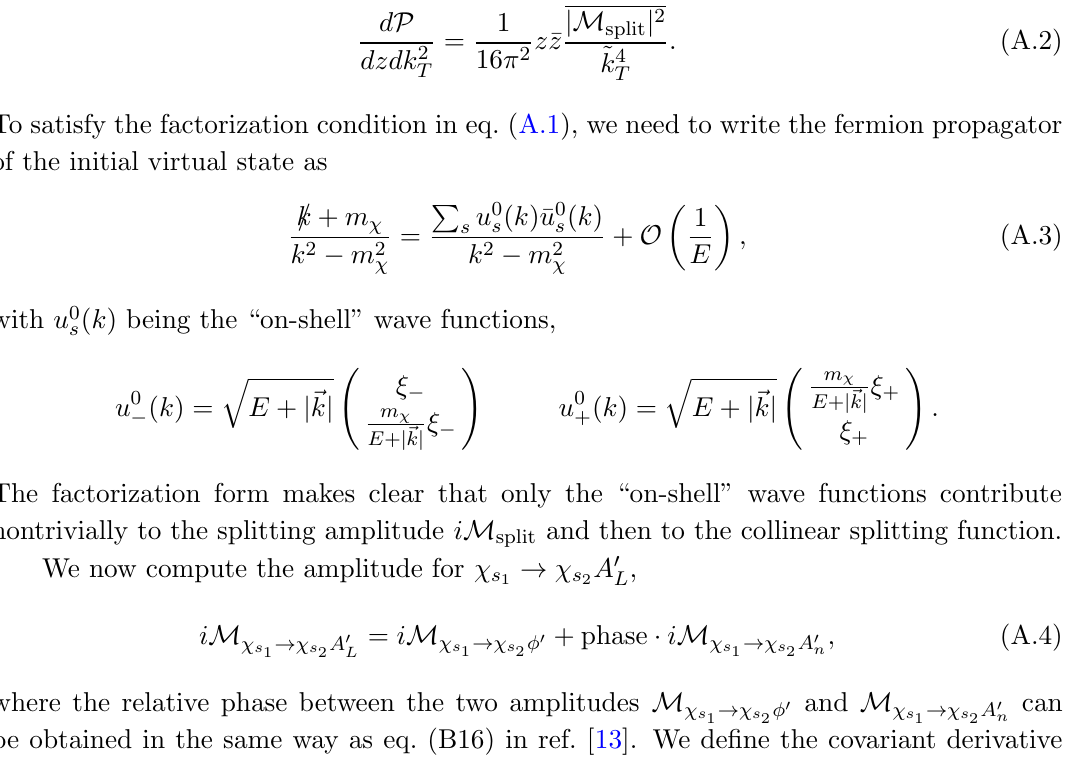
(cid:31)A 0 splitting !